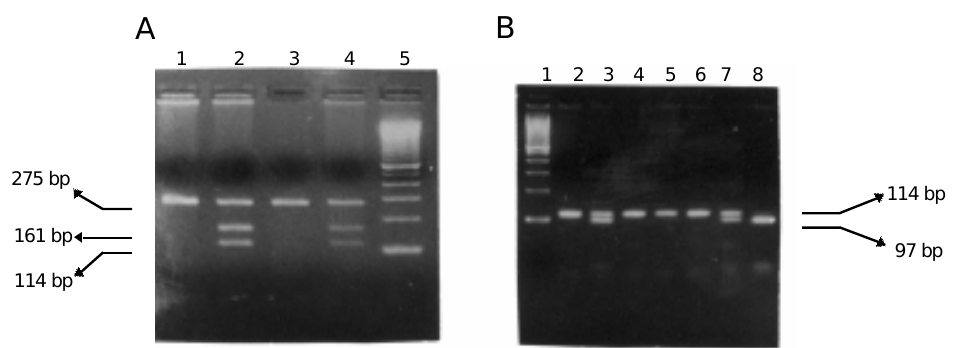
Figure 1 - Detection of the N350S and 1524+95A fi G mutations. A) Detection of N350S mutation: DNA was amplified by PCR using primers ASA 6i-5' (5' TTGATGGCGAACTGAGTGAC 3') and ASAp 6i-3' (5' CAGTGCAGG AGGCACTGAGG 3'), products digested with Bsr I and fractionated on 2.5% (w/v) agarose gel. Lanes 1 and 3 are homozygotes for the normal sequence; lanes 2 and 4 are heterozygous individuals; lane 5 is a 100-bp DNA ladder. B) Detection of 1524+95A fi G mutation. DNA was amplified by PCR using primers ASA E-5' (5' GGTTTGTGCCTGATAACTTA 3') and ASAp 8i-3' (5' TTCCTCATTCGTACCACAGG 3'), products digested with Dde I and separated on 3% (w/v) agarose gel. Lane 1 is a 100-bp DNA ladder; lanes 2, 4, 5 and 6 are homozygotes for the normal sequence; lanes 3 and 7 are heterozygous individuals, lane 8 is an individual homozygous for the mutant sequence.